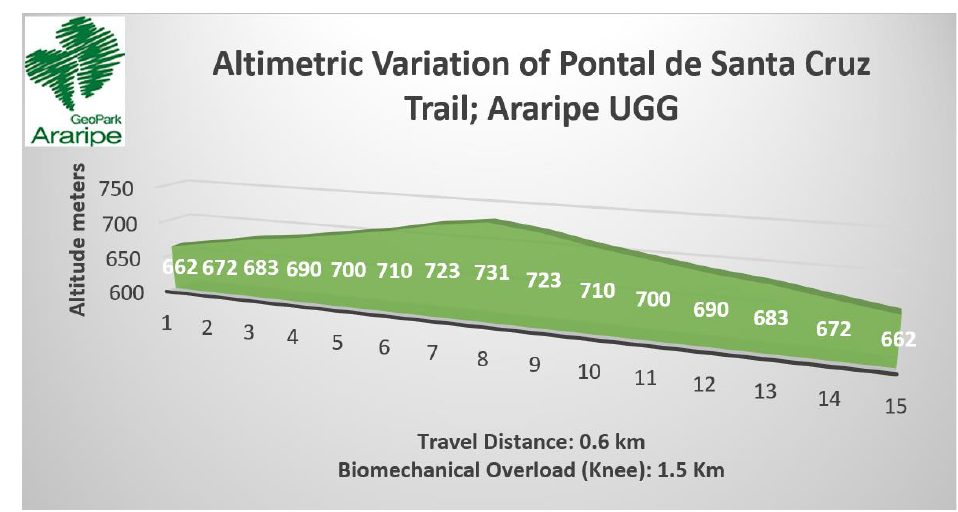
Figure 12. Altimetric Variation of Pontal de Santa Cruz trail; Araripe UGG. Table 9. Effort Index Classification by route and total of the Miss ã o Velha Waterfall Trail; Araripe The 4.0 km long Missão Velha Waterfall trail has 77 m of accumulated slope (positive) and 77 m of accumulated slope (negative) (see Table 9) with entry and exit in the same point with well-defined paths and intersections (see Table 5 and Figure 9A). As for the surface and ground, this is classified as moderate with little altimetric variation, stable